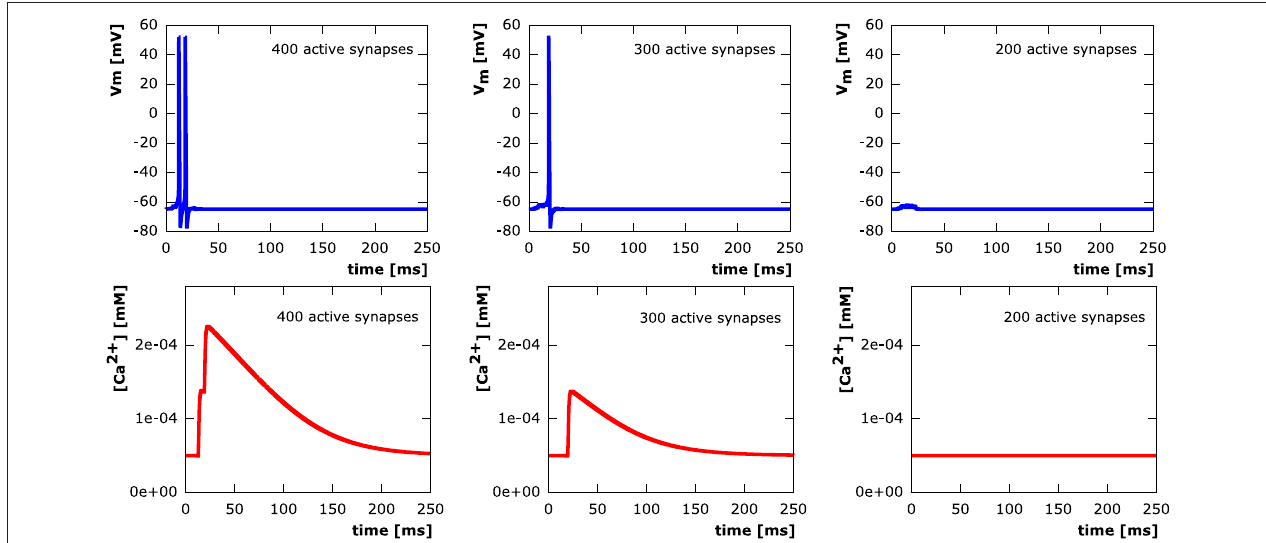
FIGURE 8 | Courses of the membrane potential in mV (row 1) and calcium concentrations in mM (row 2) measured at the soma. 400 (column 1), 300 (column 2), 200 (column 3) synaptic inputs asynchronously activated at µ onset